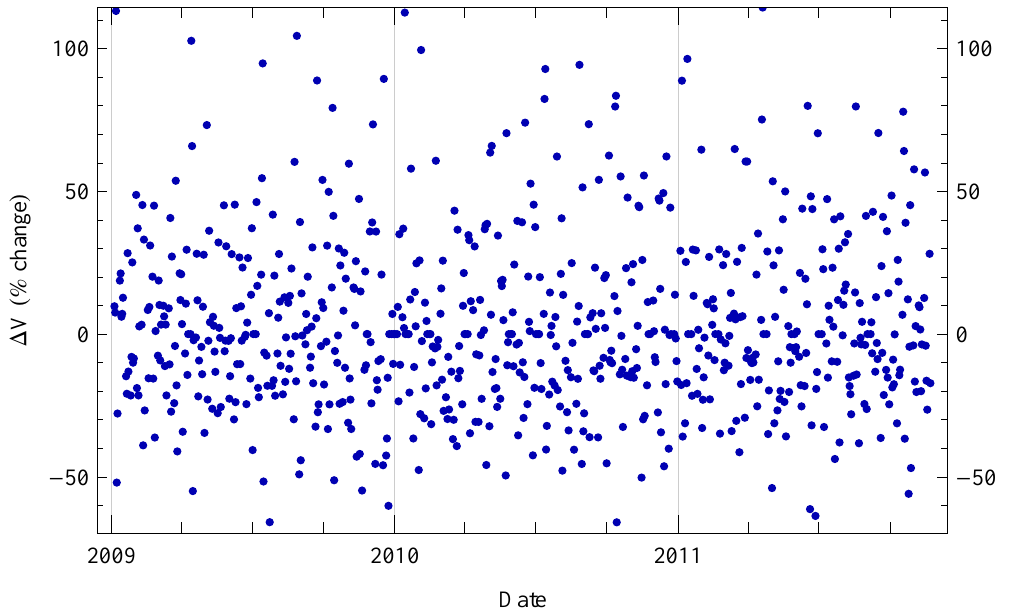
Figure 1. INTC (Intel Corp.) transaction volume change with respect to previous trading day.